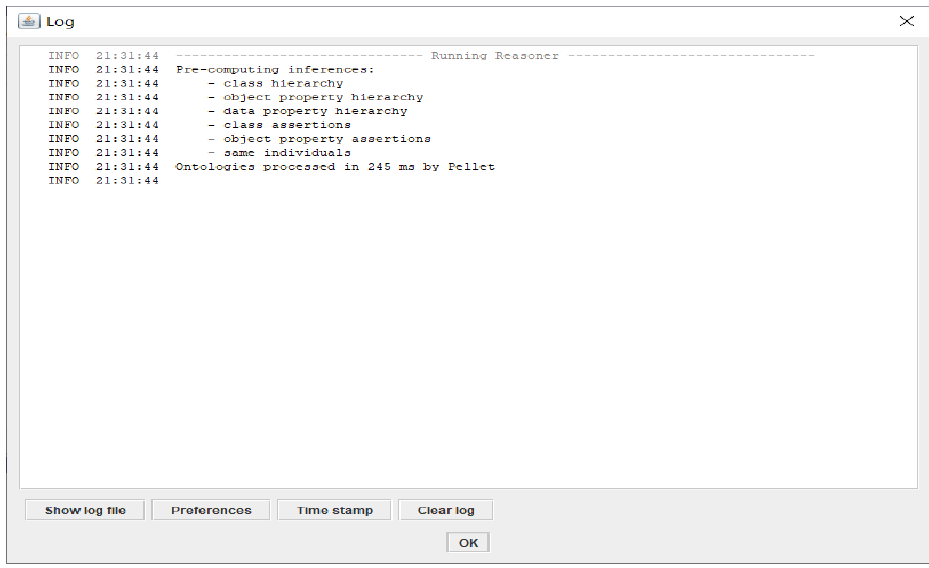
Figure 9. Execution time for the scenario described in Section 5.2, using different units. It is not necessary to execute the entire rules engine—only the rules for one context. It shows that ontologies processed in 245 ms.